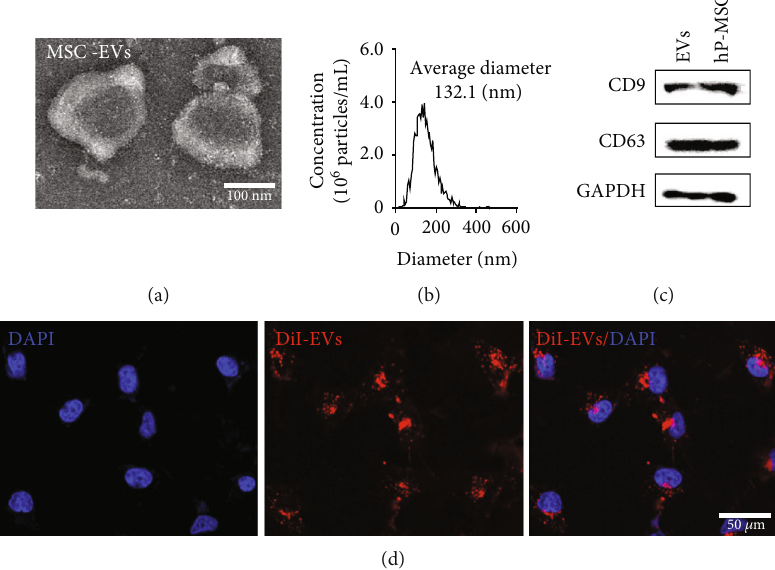
Figure 1: Characterization of EVs from hP-MSCs. (a) Representative transmission electron microscopy (TEM) image of isolated EVs. Scale bar, 50nm. (b) The diameter of EVs was around 130nm as showed by Nanoparticle Tracking Analysis (NTA). (c) Western blot results showed the expression of CD9 and CD63 in EVs and hP-MSCs. (d) The uptake of EVs (red) by HCEs. Scale bar, 50 μ